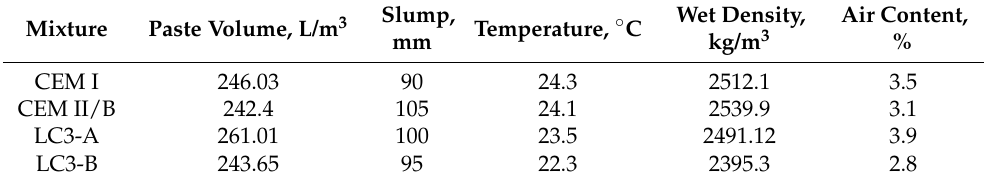
Figure 6. Total heat produced by each clay from R3 test. Table 5. Fresh properties of each mixture.